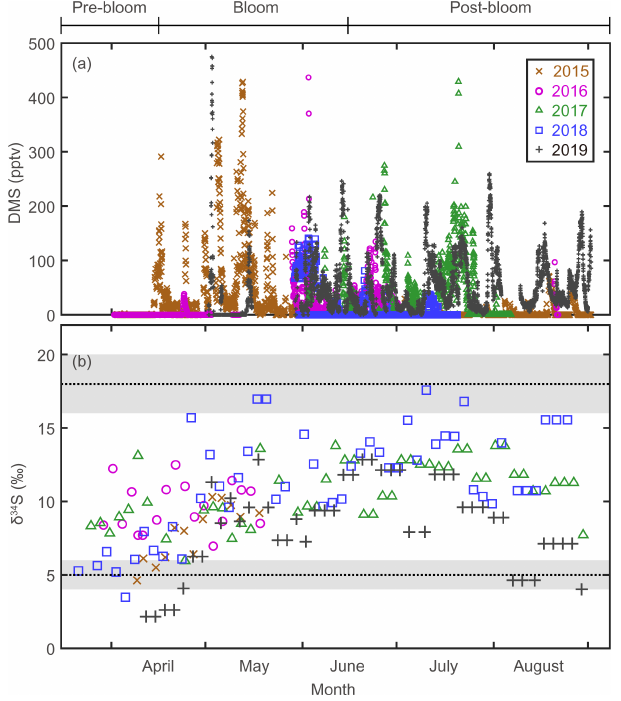
Figure 2. (a) Atmospheric DMS mixing ratios measured at the Zeppelin station, Svalbard, in 2015, 2016, 2017, 2018, and 2019. (b) Stable isotope composition of sulfate aerosols. Three end-member values; δ 34 S SS = 21 ± 0 . 1‰ for sea-salt sulfates; δ 34 S Anth = 5 ± 1‰ for anthropogenic sulfate; and δ 34 S Bio = 18 ± 2‰ for biogenic sulfates.